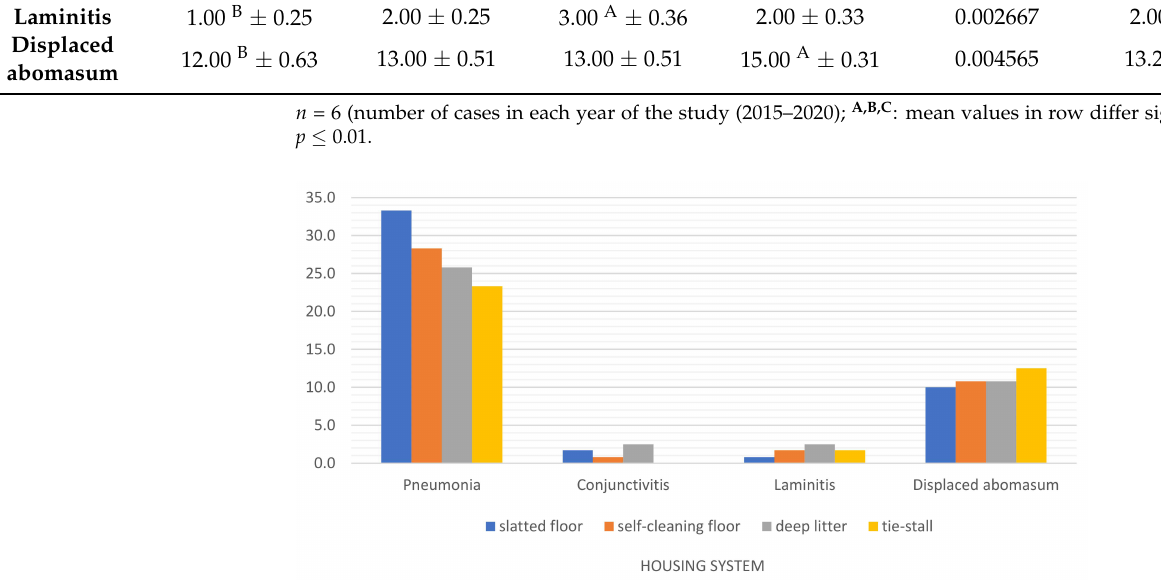
Figure 10. Prevalence of the remaining diseases in dairy cows kept in different housing systems